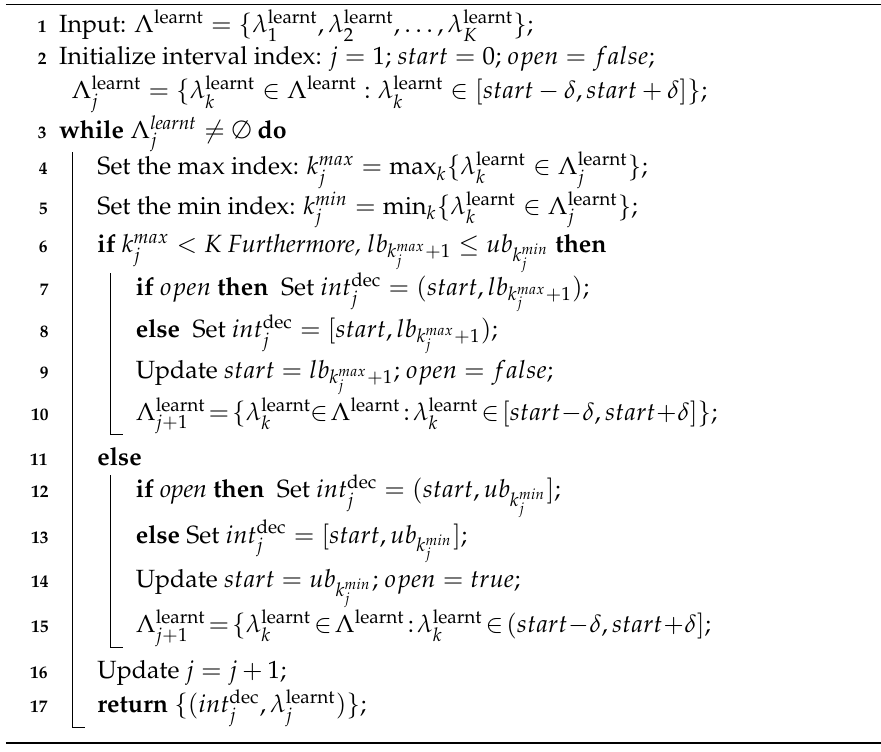
Algorithm 1: Imitative behavior deception—Decomposition of QR parameter domain into